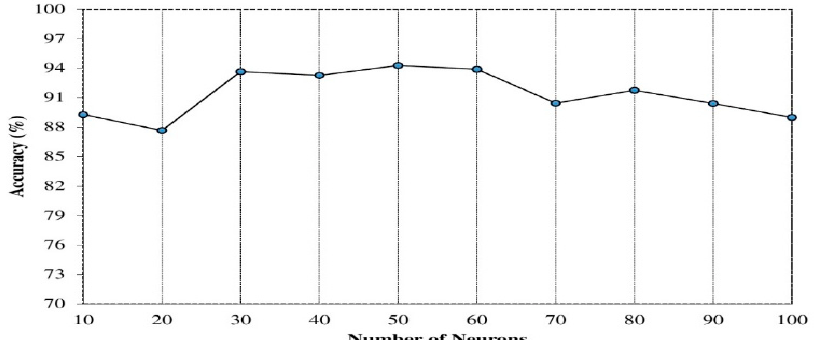
Figure 3. Impact of hidden neuron on the accuracy.